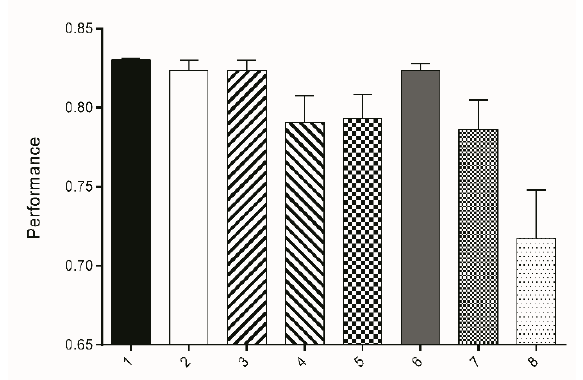
Figure 4. Bars represent the mean performance (±SD) of attribute subsets 1–8 derived from three test